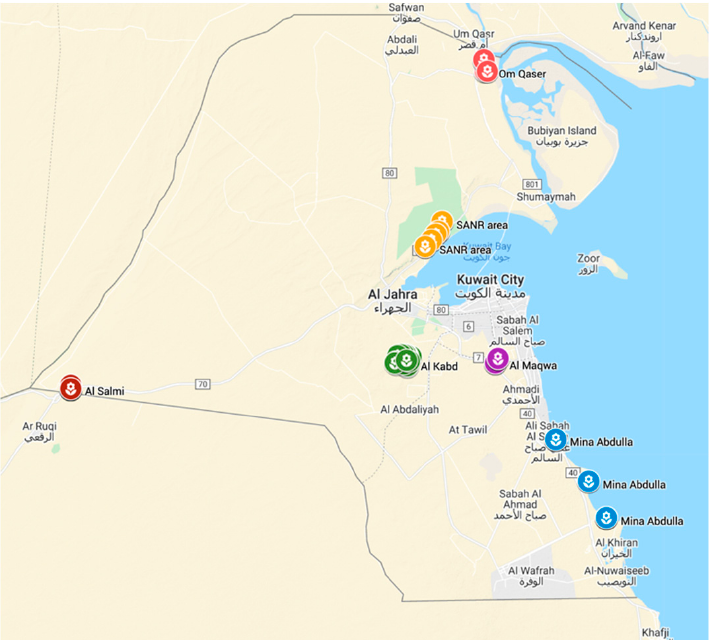
Figure 6. Map of Kuwait showing the distribution of six populations of Rhanterium eppaposum. Each population is color-coded.